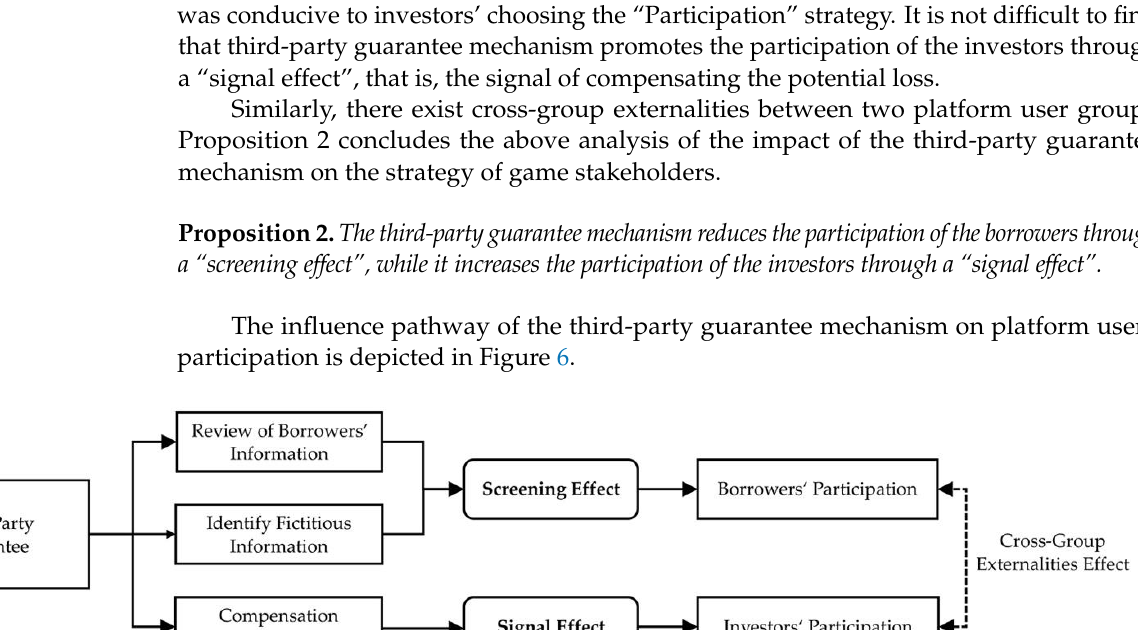
Figure 5. The influence pathway of the platform self-guarantee mechanism on platform user s’ participation . Analysis of Third-Party Guarantee Mechanism